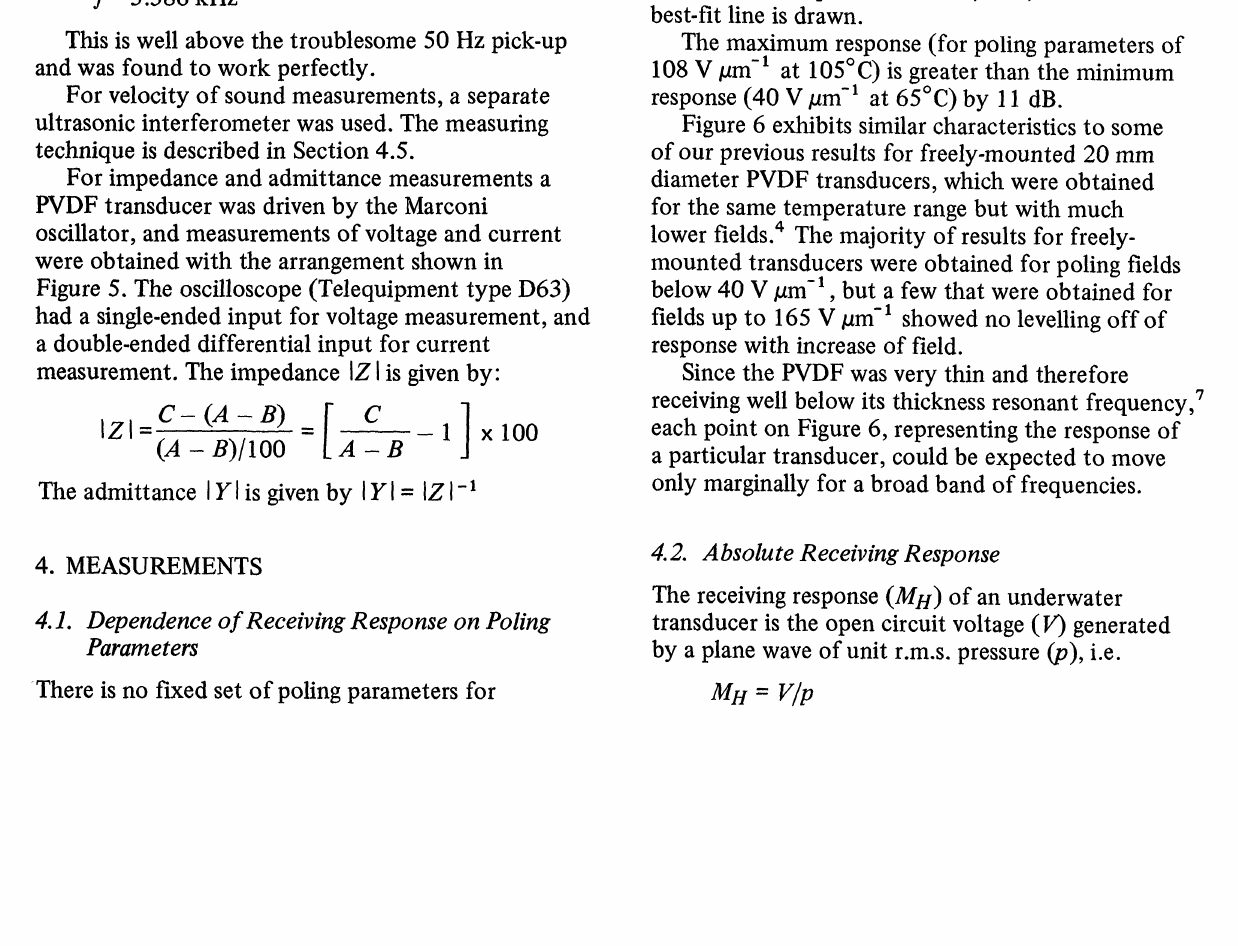
Circuit for impedance and admittance measurements.